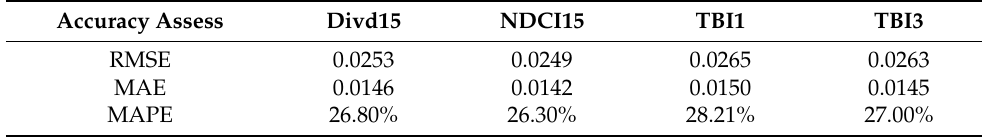
Table 7. Total accuracy statistics of the CCAPL retrieval model.